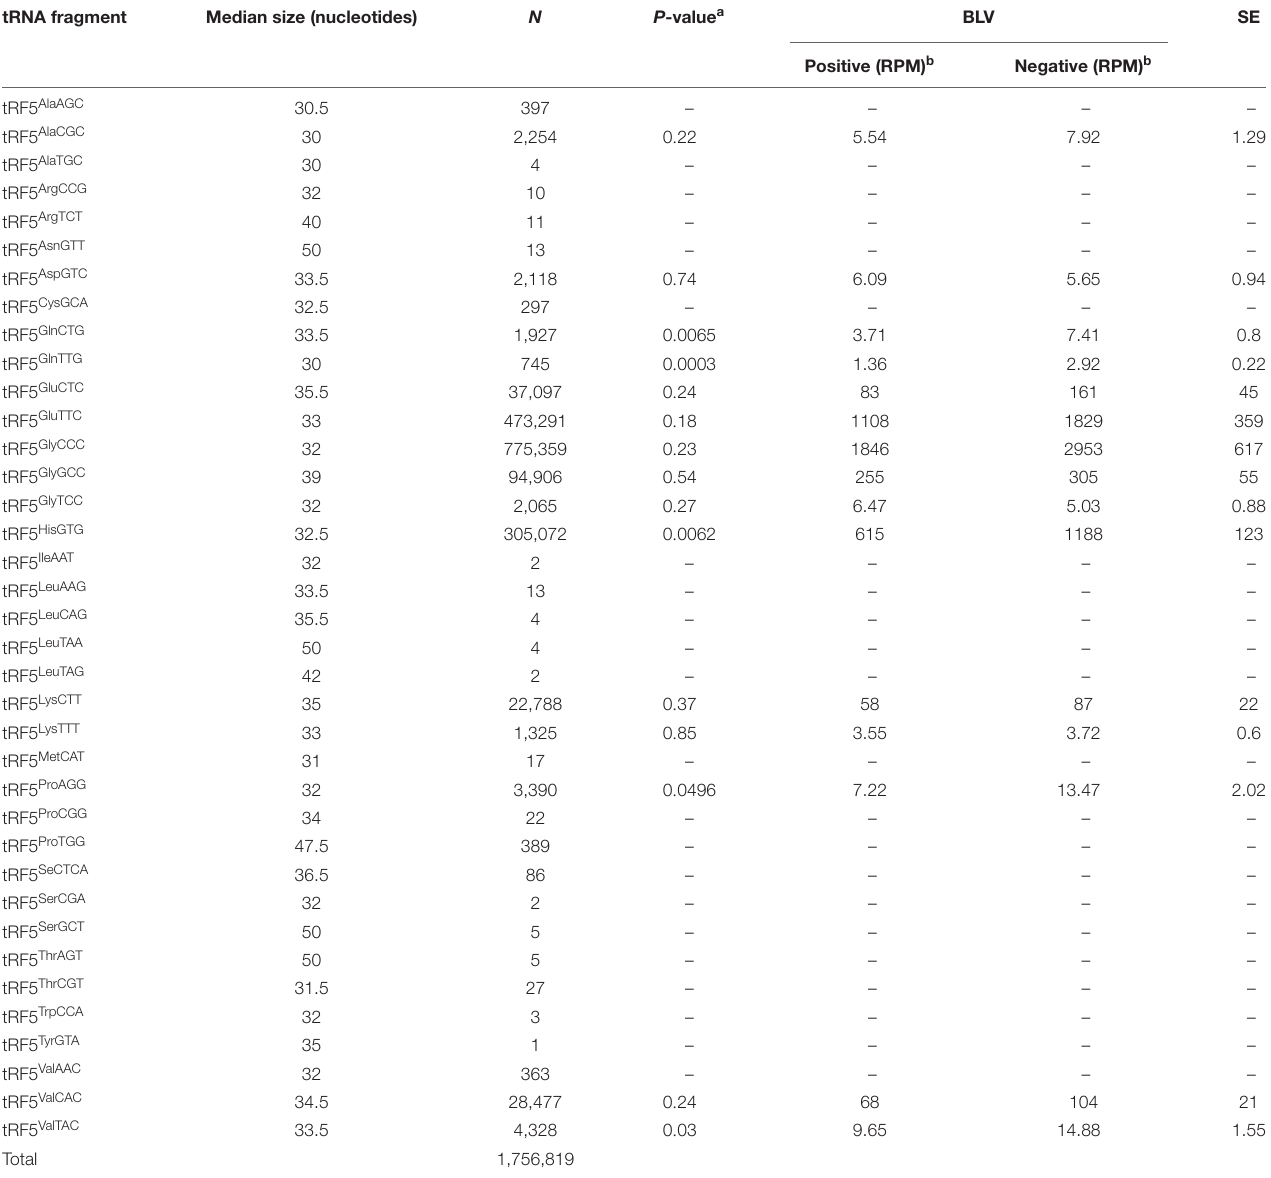
TABLE 1 | Median size of each 5 (cid:48) transfer RNA fragment (tRF5) sequences by amino acid and anticodon, number of read counts, significance ( P -value), normalized means by bovine leukemia virus (BLV) group (positive and negative), and standard errors (SE). tRNA fragment Median size